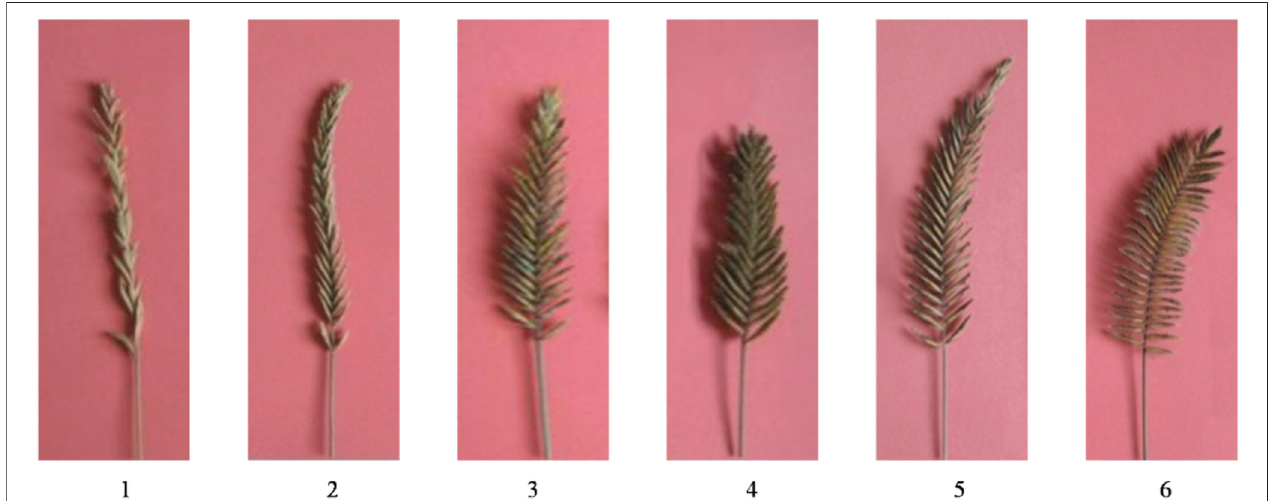
FIGURE 1 | Phenotype of the spikelet of six Agropyron species as numbered in Table 1 .